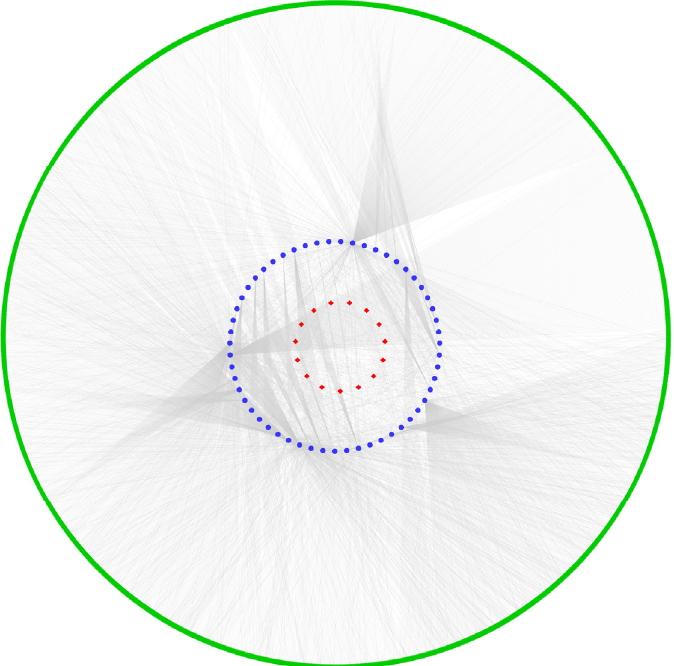
Figure 5. The ceRNA interaction network. The innermost red nodes represent DE-circRNAs. The blue nodes in the middle circle represent predicted miRNA targets. The green outer circle represents the predicted mRNAs.